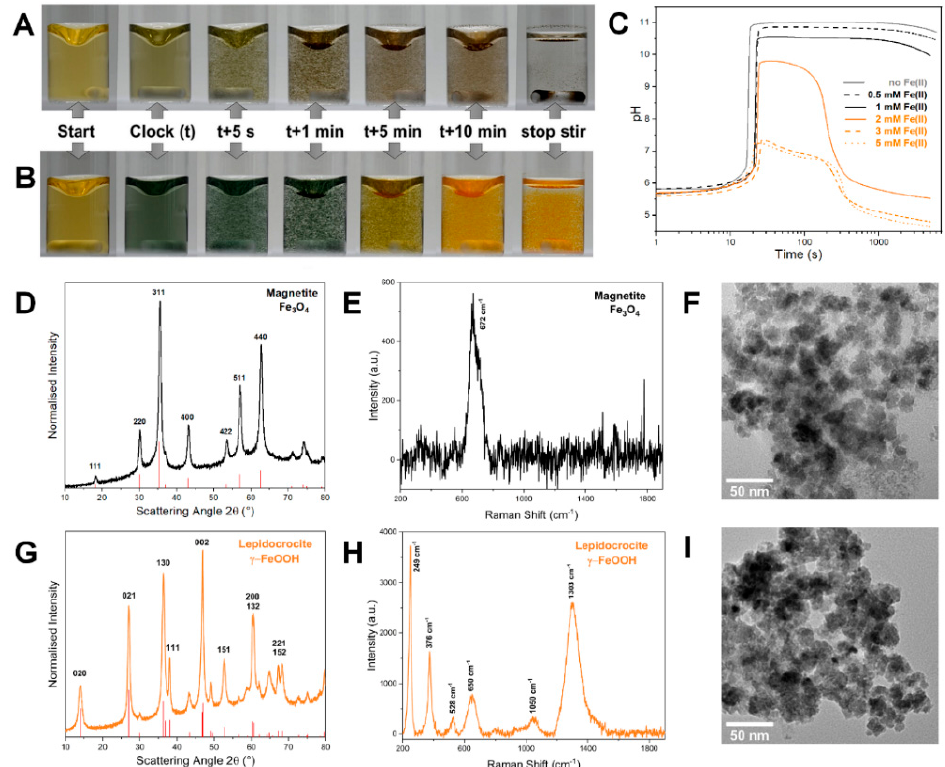
Figure 1. The MGS-Fe(II) system. ( A , B ) Photographic sequences showing the color evolution and precipitate formation for the MGS clock in presence of ( A ) 1 mM Fe(II) and ( B ) 2 mM Fe(II). In ( A ) particles are rapidly attracted by the magnetic stir bar once stirring is stopped, while in ( B ) the particles remain in suspension. ( C ) Evolution of pH over time for the MGS-Fe(II) system as a function of initial [Fe(II)]. From their XRPD diffractograms ( D , G ) and Raman spectra ( E , H ) the products have been identified as ( D , E ) magnetite and ( G , H ) lepidocrocite, respectively (the red lines represent the peaks of crystallographic standards). The TEM images ( F , I ) show the morphology of the products obtained with ( F ) 1 mM and ( I ) 2 mM